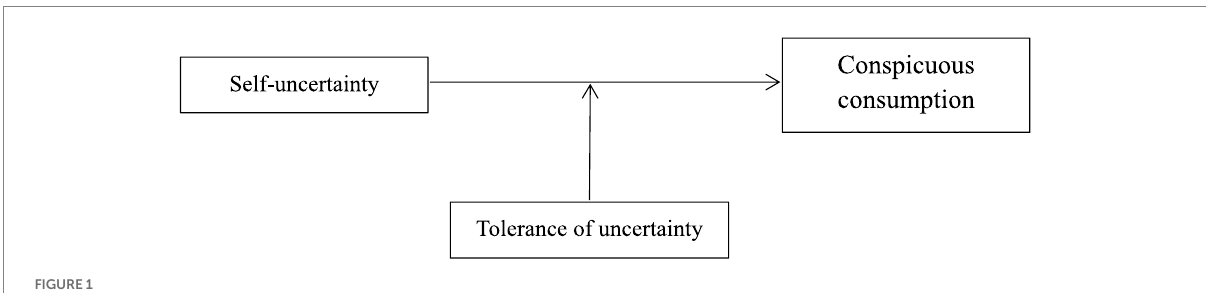
FIGURE 1 A theoretical model of the moderating effect of tolerance of